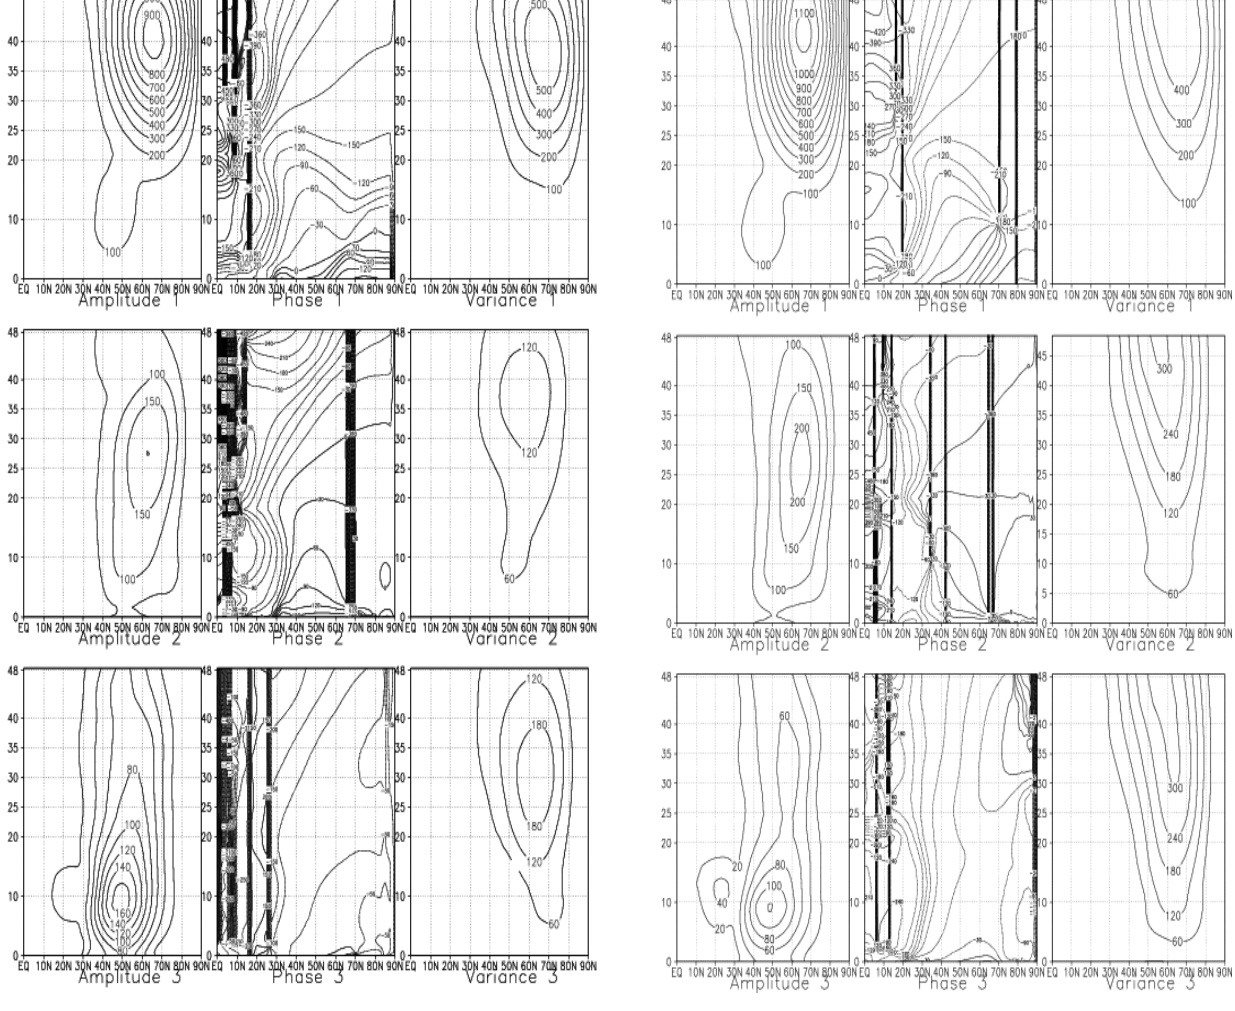
Fig. 2. January Planetary waves diagnostics of geopotential height fields for 20 winters for the LMDZ-REPROBUS model (left) and for ERA 40 reanalysis (right). Mean amplitude (left), mean phase (middle), intra-seasonnal standard deviation (right) are shown for waves with zonal wavenumber 1 (top row), 2 (middle row), 3 (bottom row).